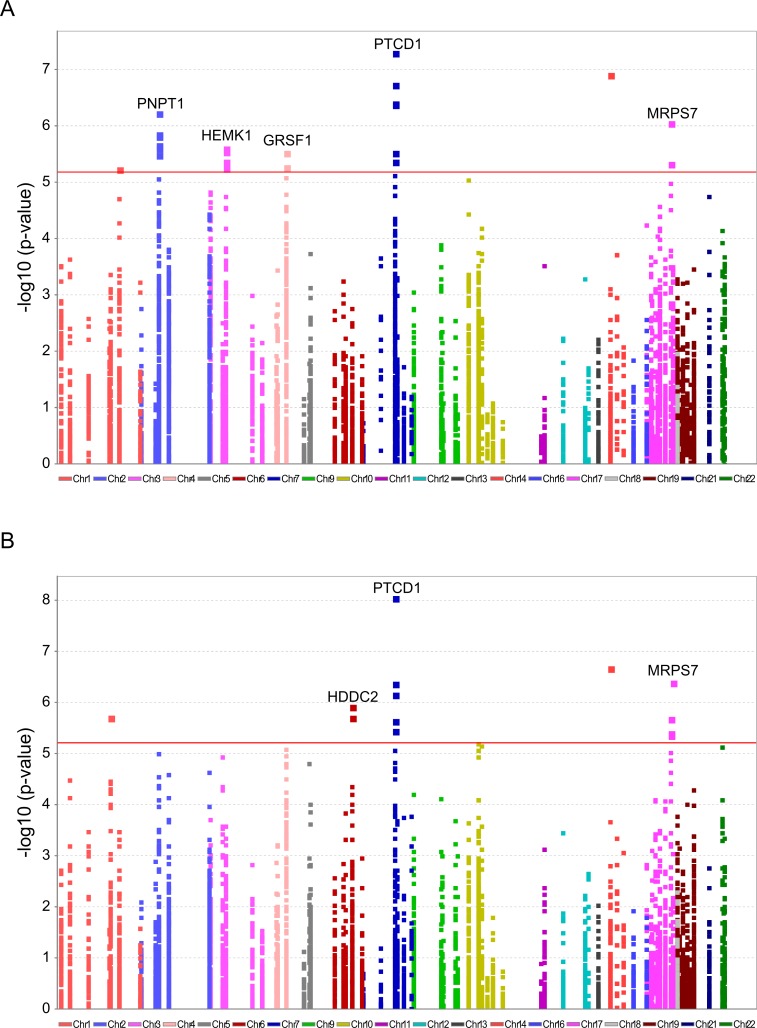
Significant association of nDNA SNPs with African-Caucasian differences in mtDNA gene expression.Annotated are nDNA genes that were repeatedly identified in the long RNA (A) and the tRNA (B) datasets. X axis–SNP distribution across human chromosomes, Y axis–logP values. P-value of significance (after Bonferroni correction = 6.52e-6 for the long RNAs and 6.11e-6 for the tRNAs) is indicated by a horizontal line.